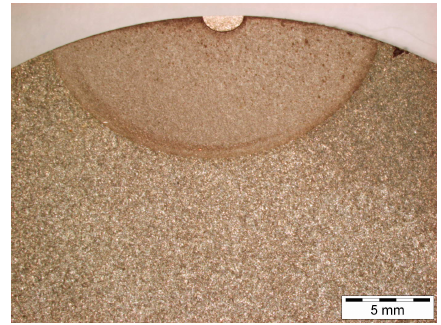
Figure 2. Representation of fracture surface for specimen utilized within CAL test #1. Metals 2019 , 9 , x